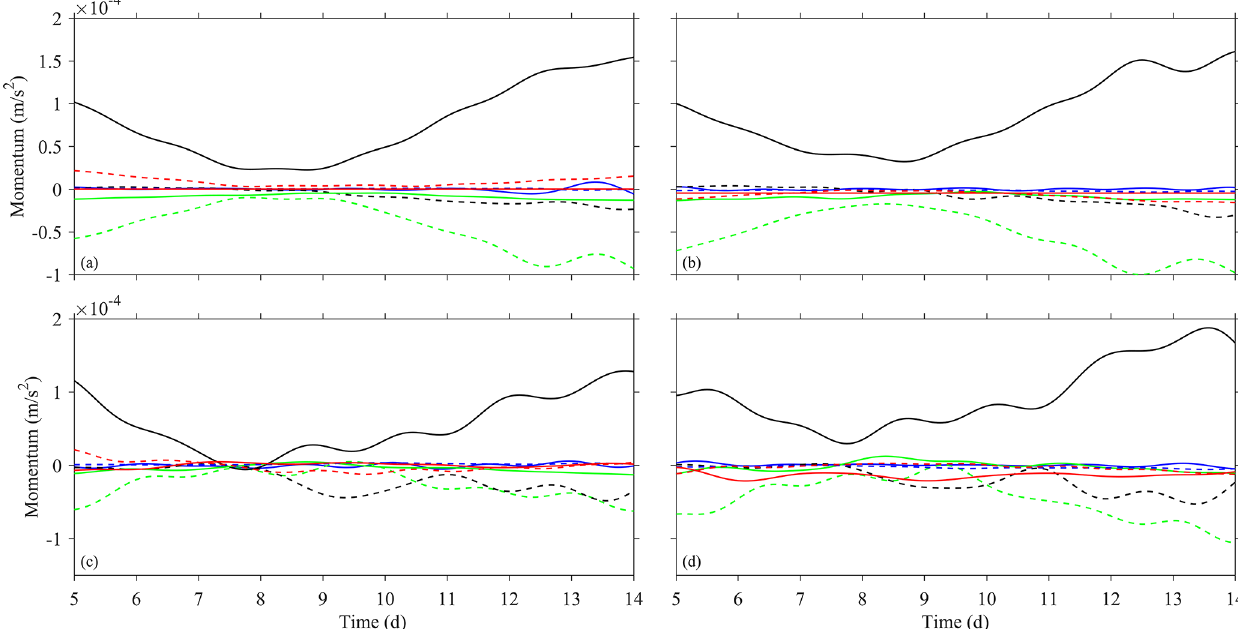
Figure 13. Temporal variations in the vertically and time-averaged terms in the momentum equations along the channel (a, c) and across the channel (b, d) from 5 to 13 February 2014 in experiment 1 (a, b) and experiment 2 (c, d) at the site labeled Mo in the northern channel. Red solid line – wind stress at river surface; red dashed line – bottom friction force; black solid line – barotropic pressure gradient force; black dashed line – baroclinic pressure gradient force; green solid line – Coriolis force; green dashed line – advection; blue solid line – local variation; blue dashed line – horizontal turbulence